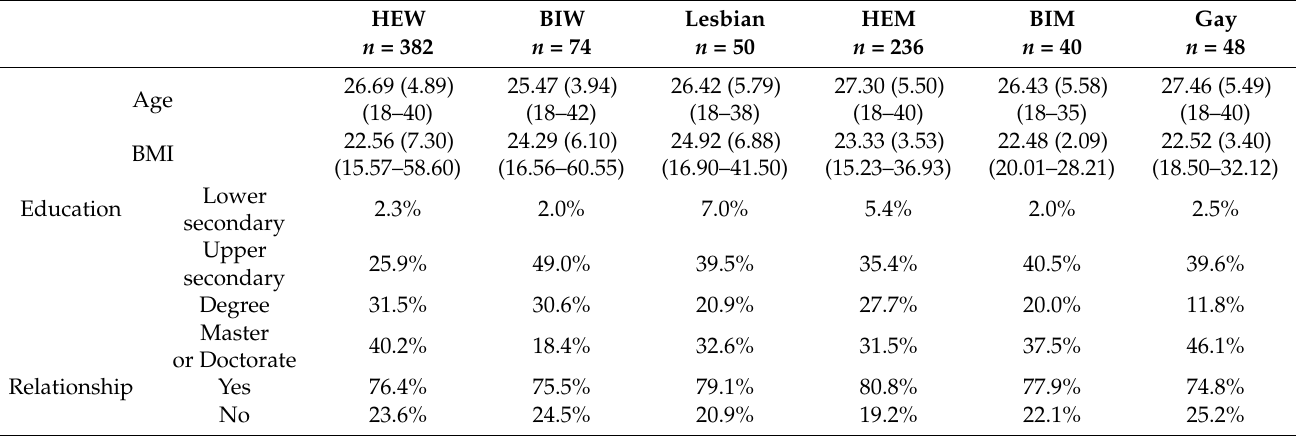
Table 1. Demographic description of the participants.